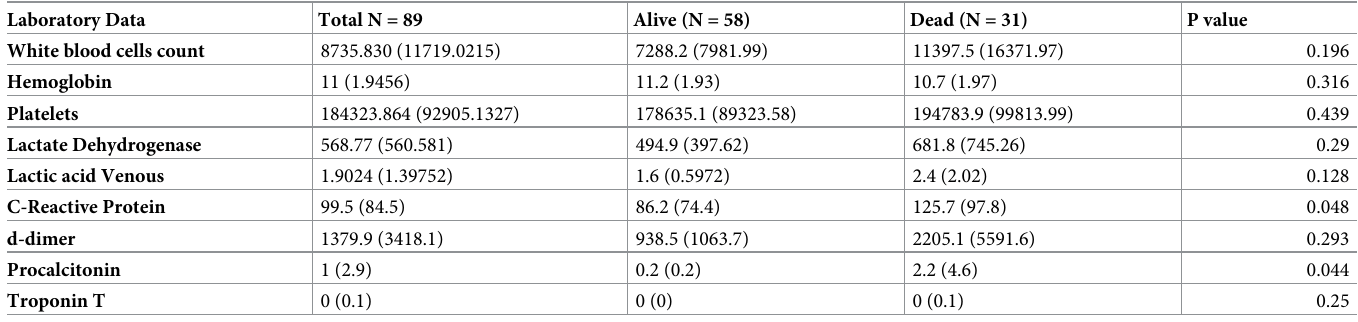
Table 3. Association of laboratory data of COVID-19 oncology patients at presentation to the emergency department with in-hospital mortality. Laboratory Data